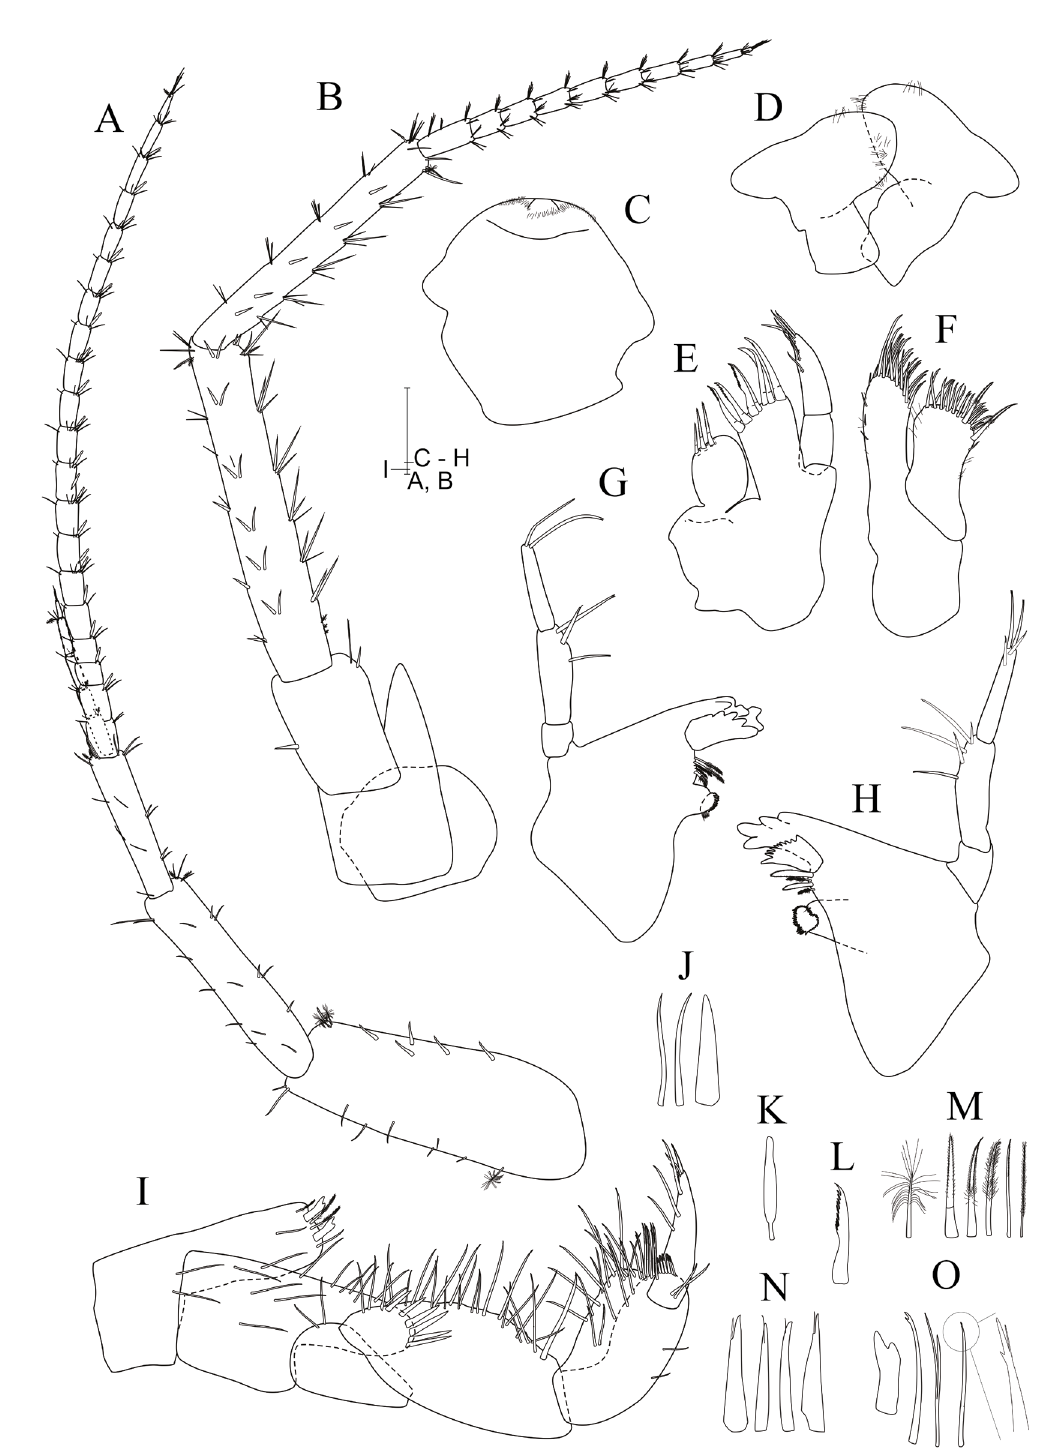
Figure 2. Spelaeogammarus ginae sp. nov., Gruna da Serra Verde cave, Serra do Ramalho, state of Bahia, Brazil. Paratype male, body length 11.31 mm; antenna 1 ( A ); antenna 2 ( B ); upper lip ( C ); lower lip ( D ); maxilla 1 ( E ); maxilla 2 ( F ); left mandible ( G ); right mandible ( H ); maxilliped ( I ); simple setae, present in various structures, the last one is more common on the uropods ( J ); aesthetasc, from antenna 1 ( K ); multicuspidate seta, from maxilla 1 outer plate ( L ); plumose setae, from antenna 1, maxilla 1 inner plate, maxilla 2 inner plate, mandibles and maxilliped, maxilliped and gnathopods, pleopods ( M ); (stout) cuspidate setae with accessory seta, present in various structures, first one more common on gnathopods and last one from telson ( N ); bifid and trifid setae, from maxilliped inner ramus, mandibles palp, gnathopods and uropod 3, pleopod 7, maxilliped palp ( O ). Scale bars: A, B = 600 μm; C–I = 200 μm; J–O = enlarged setae to see